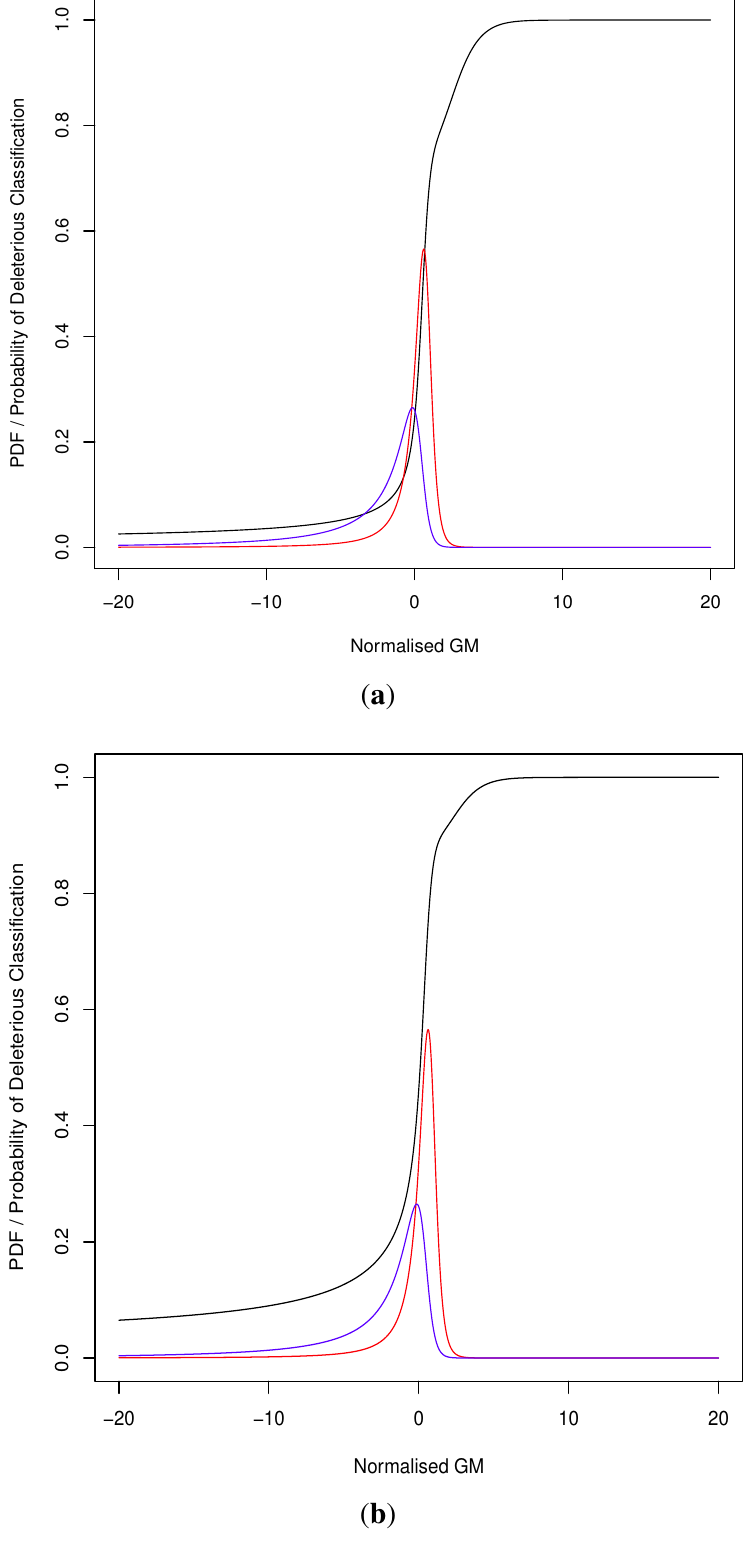
Figure S3. Posterior probability for classification as deleterious based on various prior probabilities. Deleterious (red) and neutral (blue) distributions are shown with posterior probability (black). ( a ) 20% prior; ( b ) 40% prior; ( c ) 60% prior; ( d ) 80%